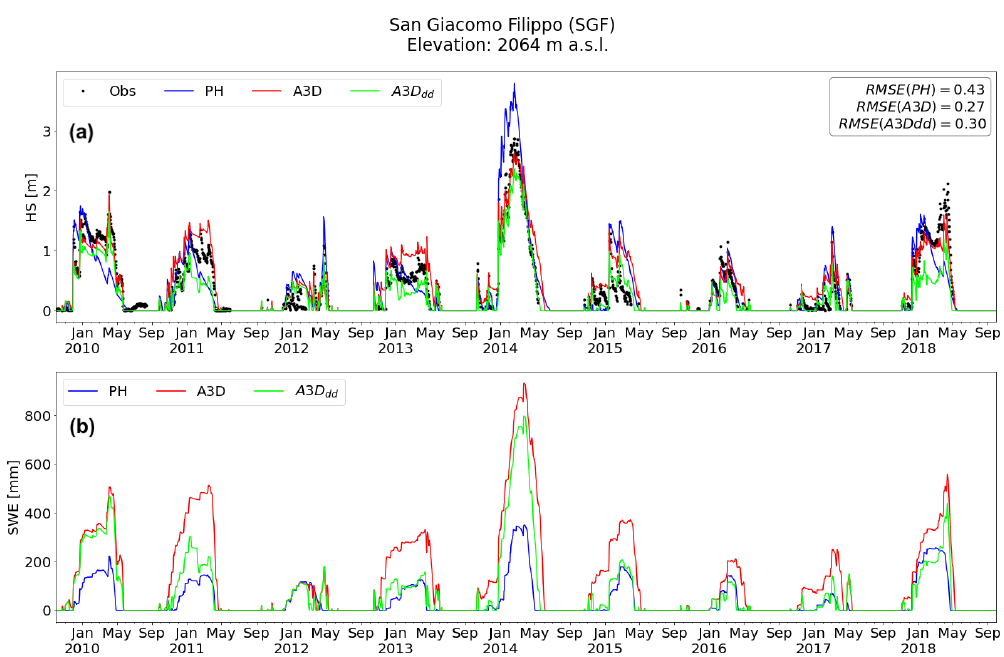
Figure 3. Snow cover analysis for the high-altitude station of San Giacomo Filippo within the Mera catchment. Panel (a) shows observed and modelled HS, and panel (b) shows modelled